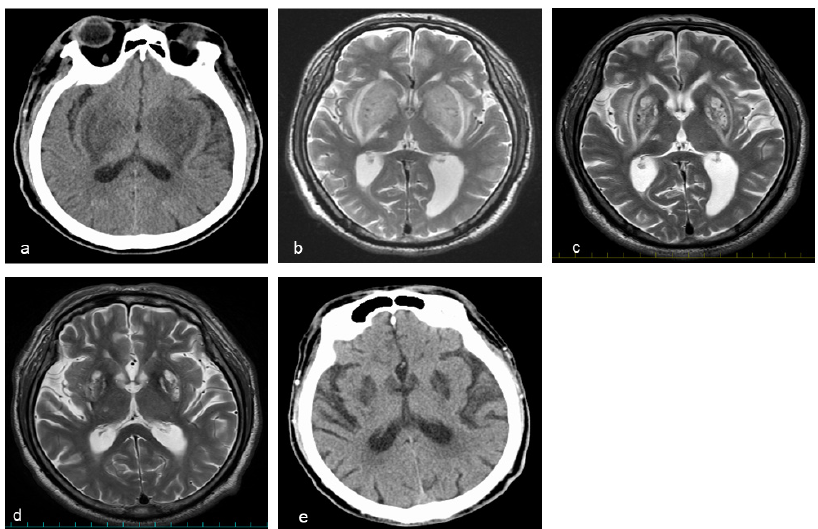
Figure 1. a , e Head computed tomography (CT) and b–d head MRI (T2-weighted image). a, b High-resolution lesions in the bilateral symmetrical basal ganglia were evident at admission. c, d The bilateral symmetrical basal ganglia lesions gradually improved on the 18 th hospital day and at three-month follow-up. e However, the basal ganglia lesions remained at eight-month